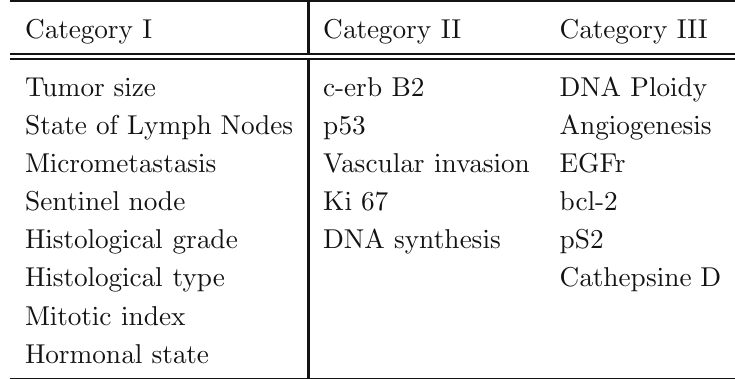
Table 1 Biomarkers in breast